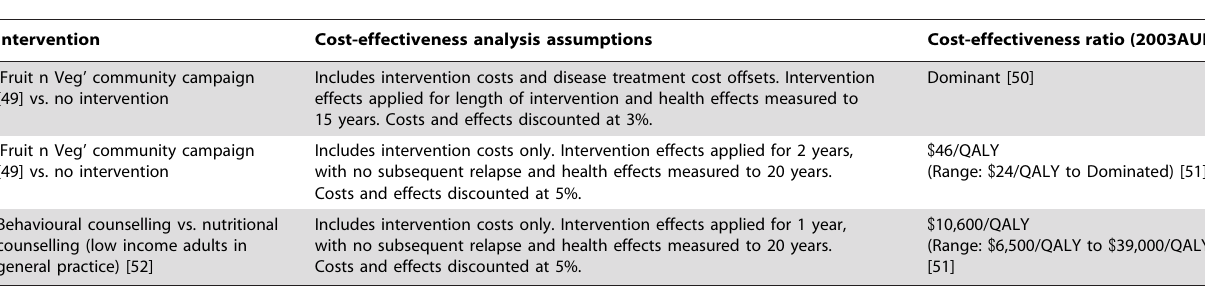
Table 1. Cost-effectiveness analyses of interventions to promote fruit and vegetable consumption.